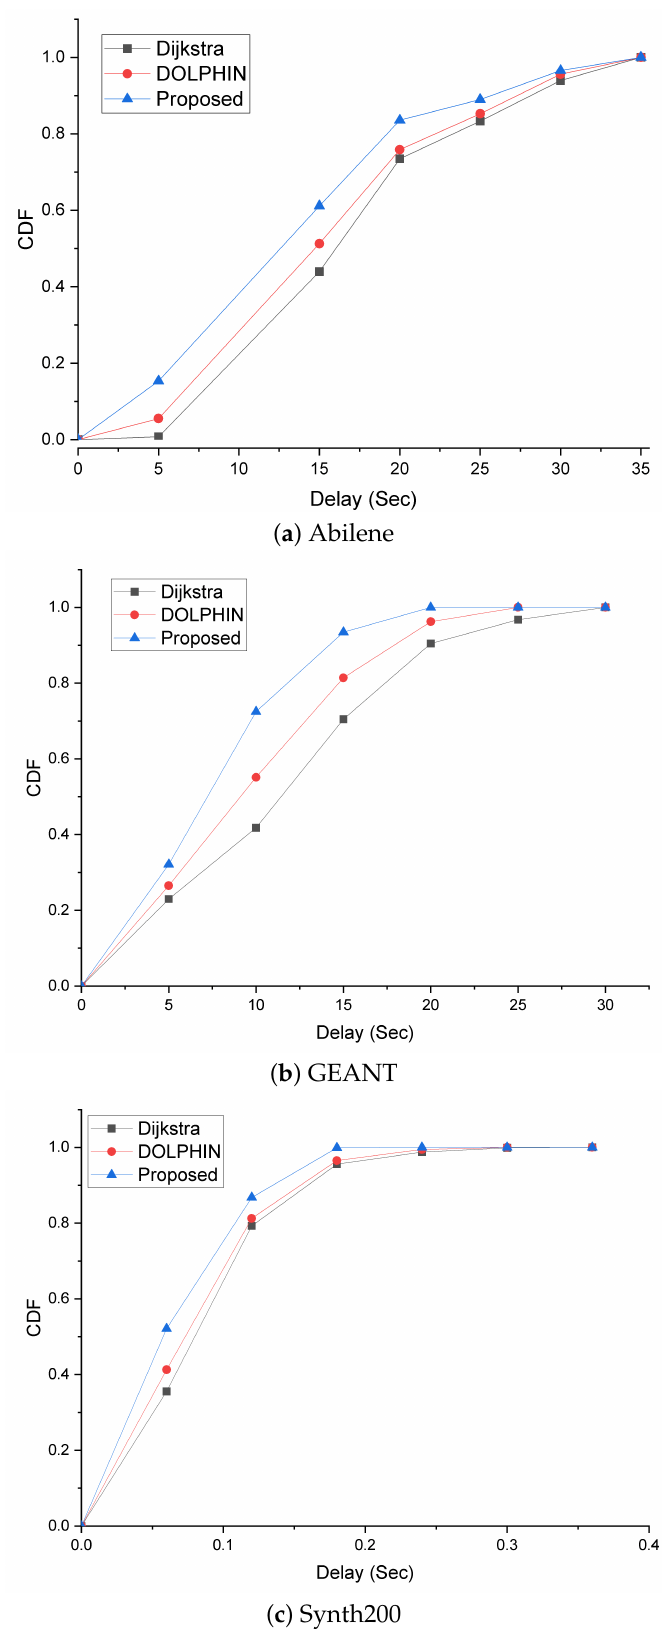
Figure 8. Maximum delay